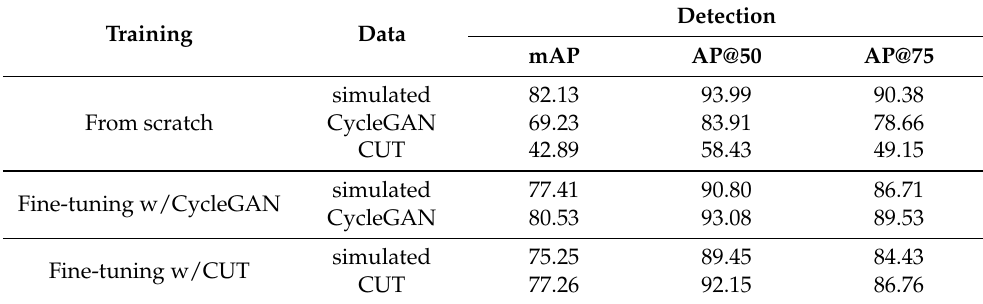
Table 2. Detection results obtained on simulated images, before and after domain adaptation, in terms of mAP and AP at 50% and 75% of IoU. The first column refers to the training process and the second specifies the test data for each scenario; for example, the 3rd row refers to the performance when training on simulated images and testing on CycleGAN converted images, while the 6th row refers to fine-tuning and testing on simulated images converted by CycleGAN. We include the results from [10] for